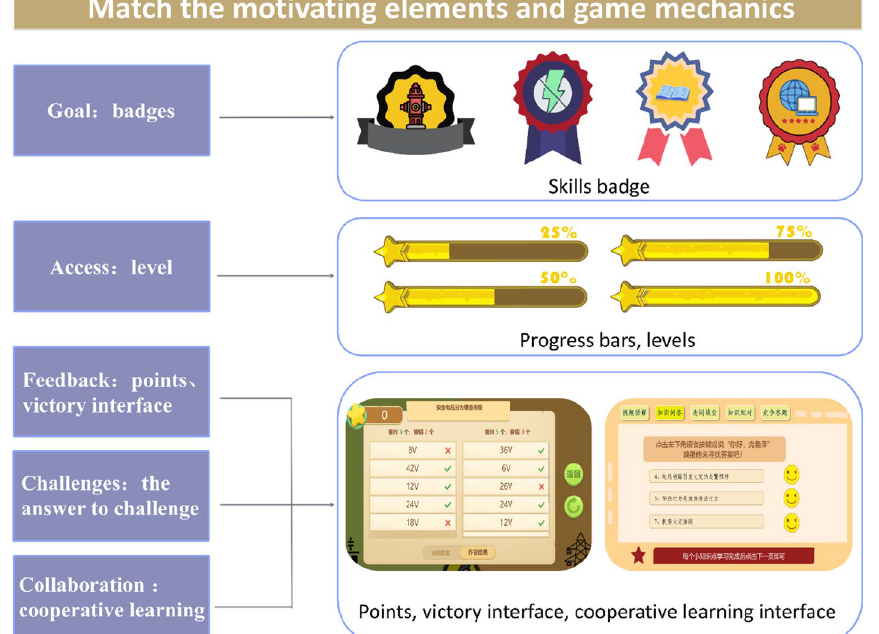
Fig. 4 Match the motivation needs and game